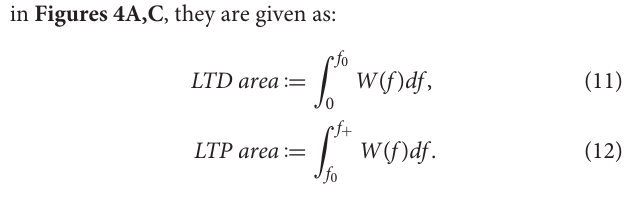
weight. As before, we set the frequency of the background synaptic activity at 1 Hz. The numerical results are plotted in Figure 3